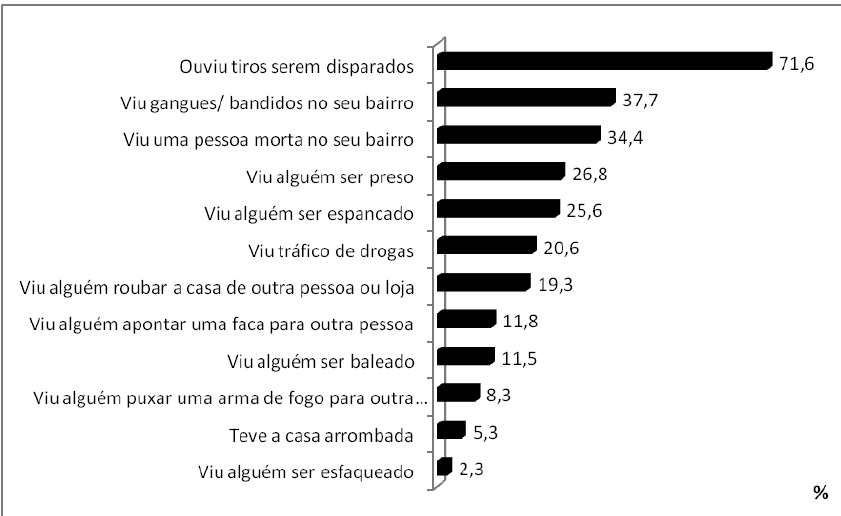
Figura 1 . Prevalência da exposição à violência comunitária em crianças e adolescentes de escolas municipais de São Gonçalo – RJ ( N